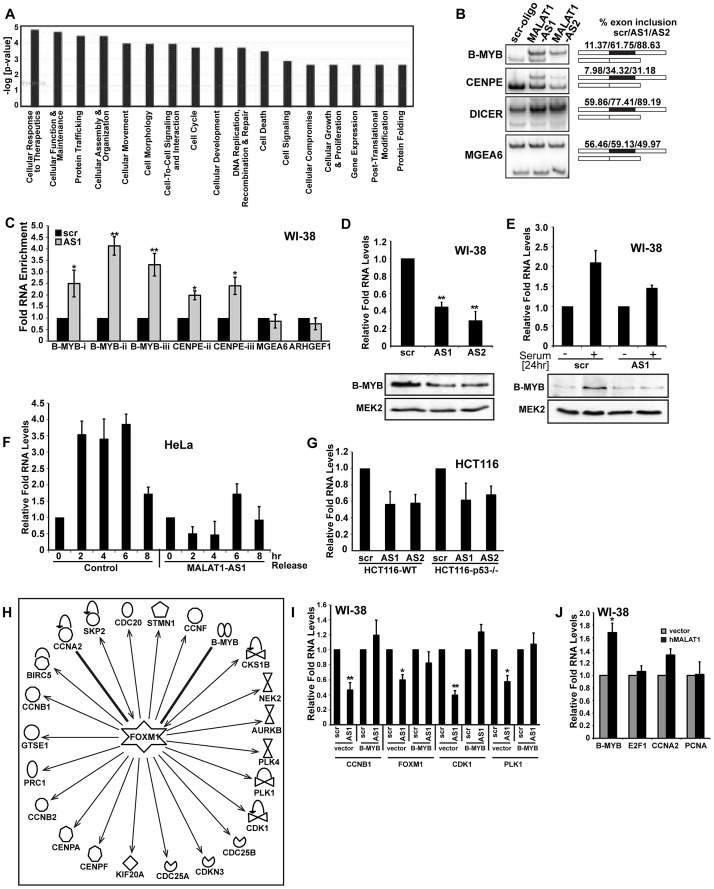
MALAT1 regulates mitotic gene expression by controlling the levels of B-MYB.(A) Top significant biological processes for genes whose alternative splicing was affected in MALAT1-depleted HDFs. (B) RT-PCR analysis using primers specific to exons in MALAT1-regulated alternative exons in indicated mRNAs show changes in alternative splicing in MALAT1-depleted WI-38 cells. Alternative exon-included (upper band) and -excluded bands (lower band) and the percentage change of alternative exon inclusion between scr-oligo/MALAT1-AS oligos (AS1 and AS2) observed is shown. Note that the alternative splicing of MGEA6 pre-mRNA is not altered upon MALAT1 depletion. (C) qRT-PCR analyses of SRSF1 RNA-IP samples from control and MALAT1-depleted (AS1) WI-38 cells reveal increased association of SRSF1 to B-MYB and CENPE mRNA. B-MYB-i-iii and CENPE-ii-iii correspond to separate sets of primers from independent exons of B-MYB and CENPE mRNA. (D) The relative expression and (E) serum-induced activation of B-MYB is determined by qRT-PCR and immunoblot analyses using RNA and protein from control (scr) and MALAT1-depleted (AS1 & AS2) WI-38 cells. (F) G1/S synchronization (0 hr) and release (2–8 hr) in control and MALAT1-depleted HeLa cells reveal reduced levels of B-MYB upon MALAT1 depletion as observed by qRT-PCR analyses. (G) The relative expression of B-MYB is determined by qRT-PCR analyses using RNA from control (scr) and MALAT1-depleted (AS1 & AS2) HCT116-WT and HCT116 p53 −/− cells. (H) Gene network analyses (Ingenuity pathways) indicate that a large number of mitotic specific genes that are downregulated upon MALAT1 depletion are regulated by B-MYB and FOXM1. Note that all the genes mentioned in this figure are downregulated in MALAT1-depleted fibroblasts. (I) Transient expression of B-MYB rescues the expression of mitotic specific genes in MALAT1-depleted WI-38 cells. (J) Relative expression of indicated genes is determined by qRT-PCR analyses in RNA from vector and MALAT1 overexpressed WI-38 cells. Note the increased B-MYB mRNA levels in MALAT1 overexpressed cells. Mean ± SEM, *p<0.05, **p<0.01 and ***p<0.001.